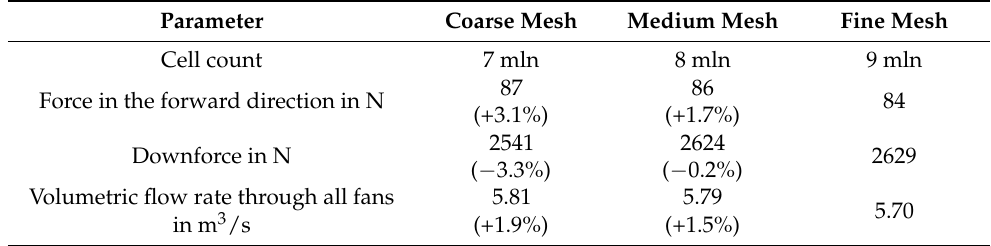
Table 1. Grid convergence test results.